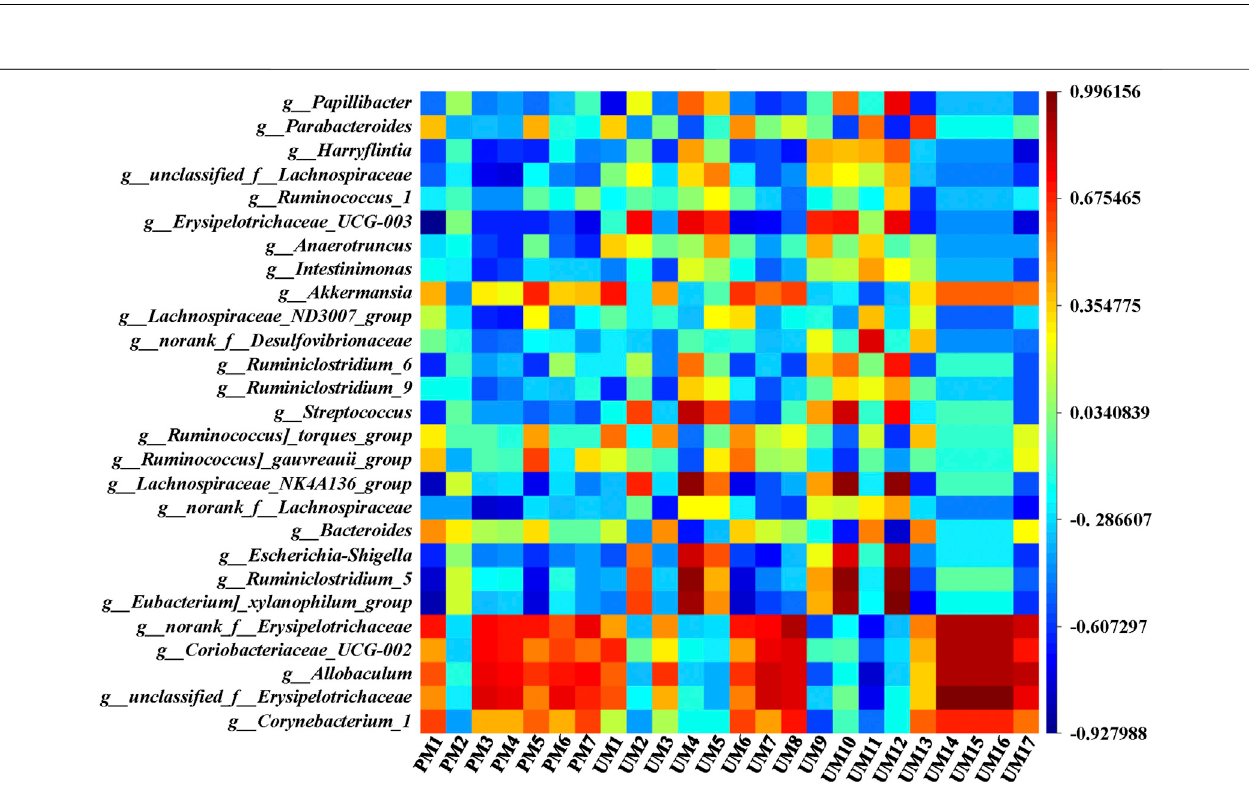
FIGURE 8 | Correlation analysis between metabolites and intestinal fl ora.